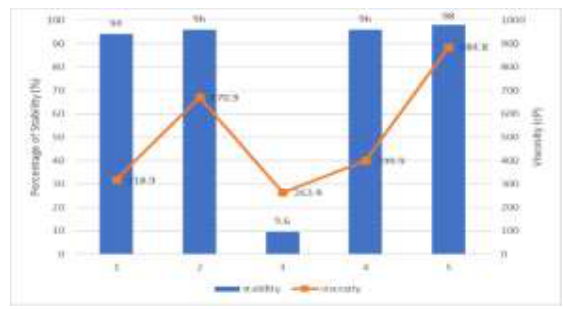
Figure 4: Relationship between viscosity and stability of an